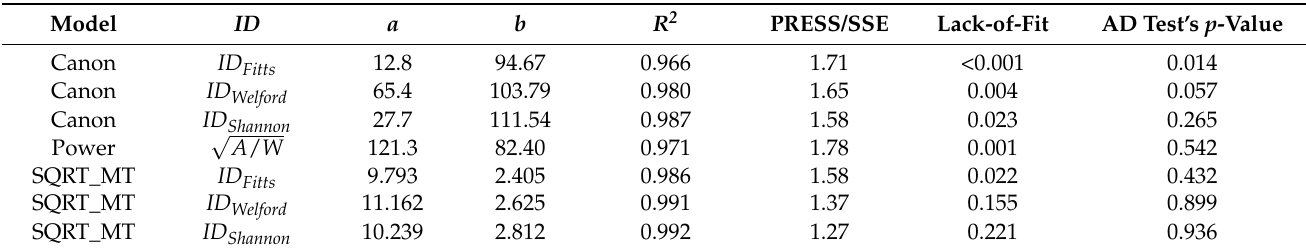
Table 1. Performances of 1 oz stylus tapping in the Canon, Power, and SQRT_MT models using Fitts’ data [1]. The SQRT_MT model performed better than the Canon and Power models in all statistics.